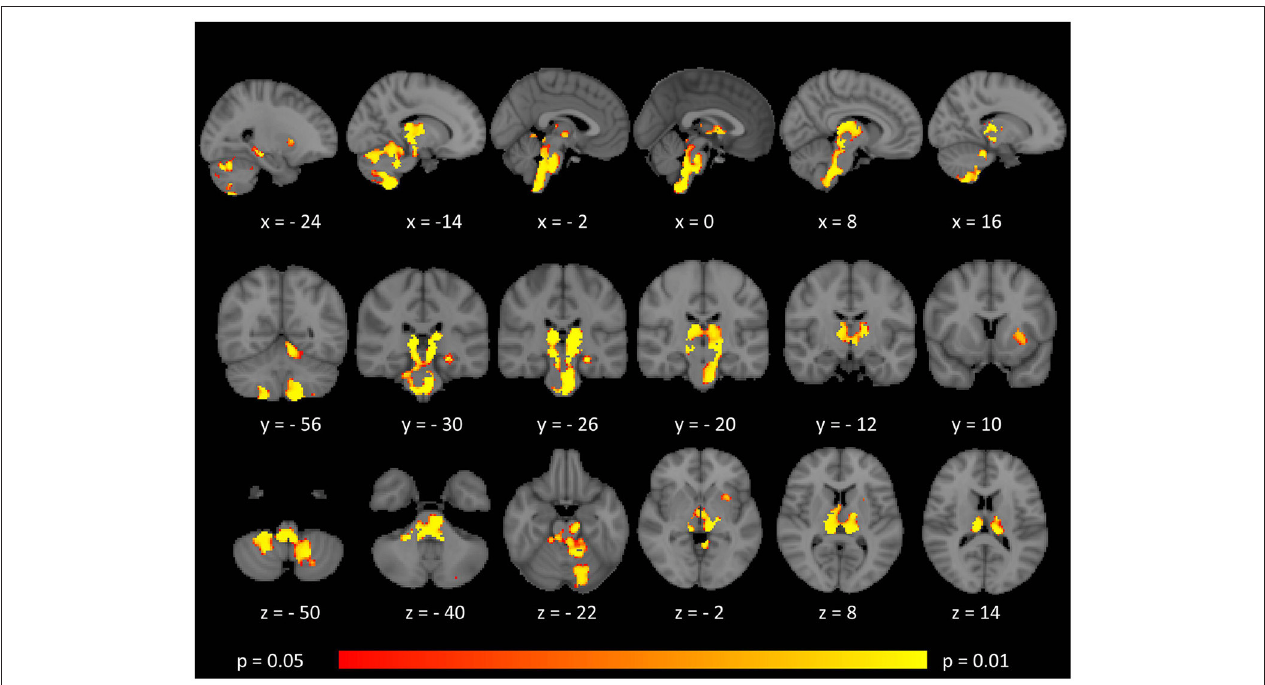
FIGURE 1 | Patterns of gray matter atrophy in multiple sclerosis patients with gave-evoked nystagmus compared to healthy controls identified by voxel-based morphometry at p < 0.05 FWE adjusted for age and gender. Representative axial, coronal, and sagittal views are presented with corresponding MNI coordinates.